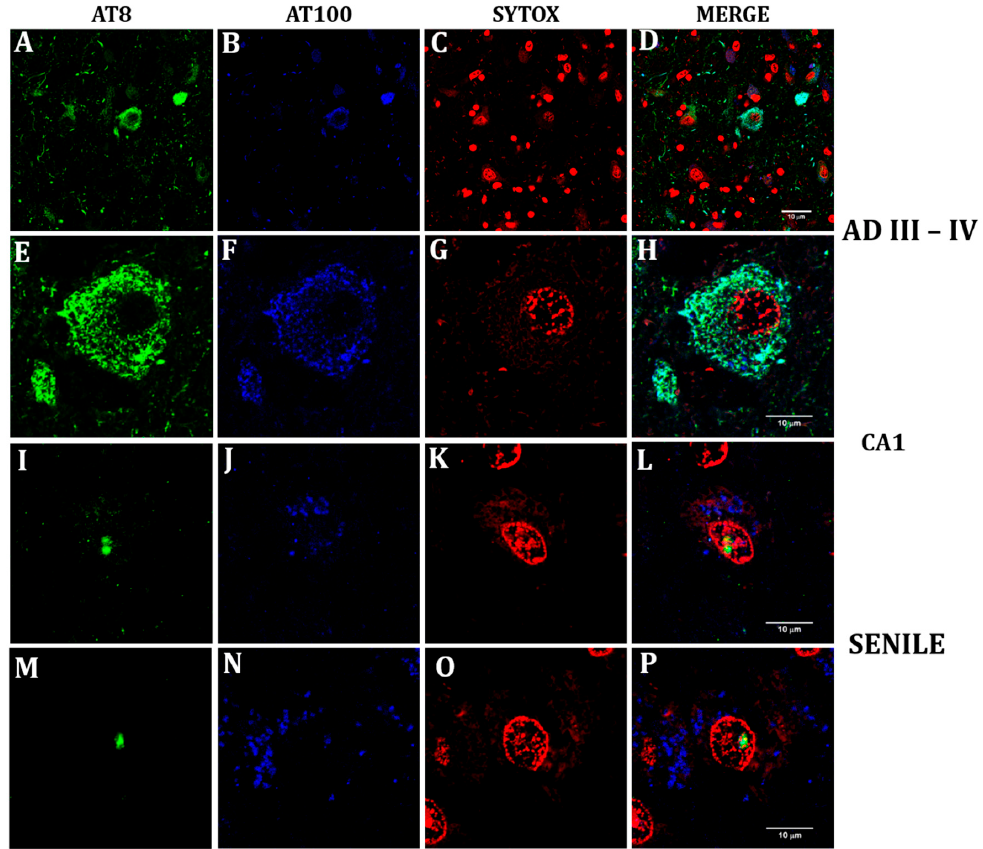
Figure 2. Confocal analysis of nuclear and cytoplasmic phosphorylated Tau in senile CA1 hippocampal neurons and at AD III-IV Braak stages . Colocalization of two phosphorylation sites (S212-T214) and (S202-T205) was tested with AT100 and a rabbit monoclonal antibody (AH36), which recognizes the same site as AT8 antibody. The term AT8 was kept in order to follow in line with the previous figure. View of CA1 region at AD III-IV showing the characteristic tauopathy through AT100 (blue), AT8 (green) and nuclei stained in red with SYTOX ( A – D ). Detail of a neurofibrillary tangle with cytoplasmic AT100 ( E ) and AT8 ( F ). Nuclear presence of the site recognized by AT8 ( I , M ), and of AT100 site (J) in a neuron from senile hippocampus. AT100 was also identified in the cytoplasm of senile neurons ( N , P ). Senile CA1 neuronal nuclei can simultaneously express AT8 and AT100 ( L ), or nuclear AT8 and cytoplasmic AT100 ( P